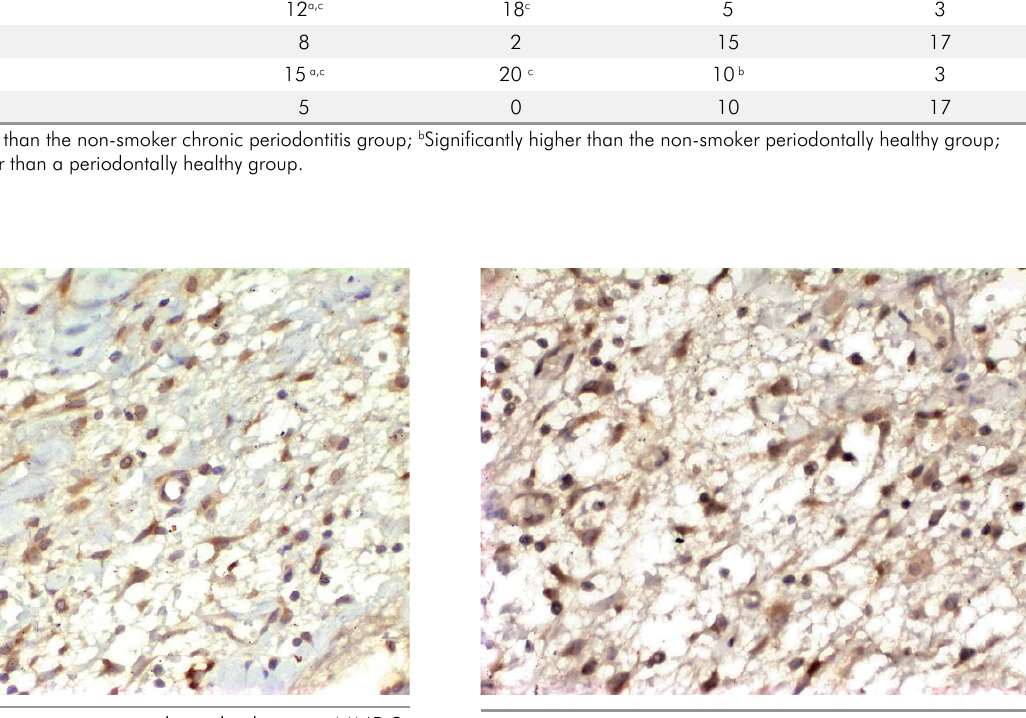
Figure 4. By immunostaining with antibodies anti-MMP-2, positive cytoplasmic staining with MMP-2 observed in a majority of fibroblasts. Inflammatory cells showing negative staining with mixed fibroblasts are noteworthy. (Immunostaining with antibodies anti-MMP-2, x400) (CP